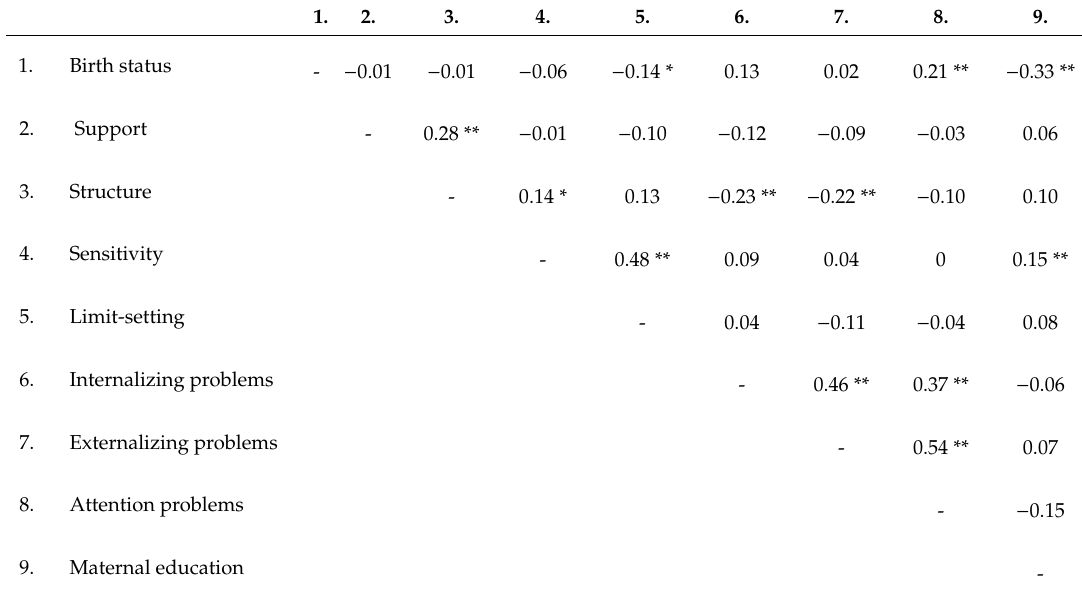
Table 3. Correlations between study